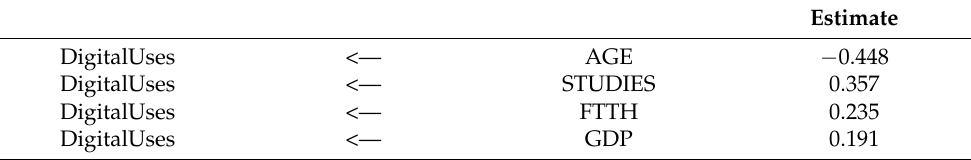
Table A14. Standardized Regression Weights: (Group number 1-Default model).